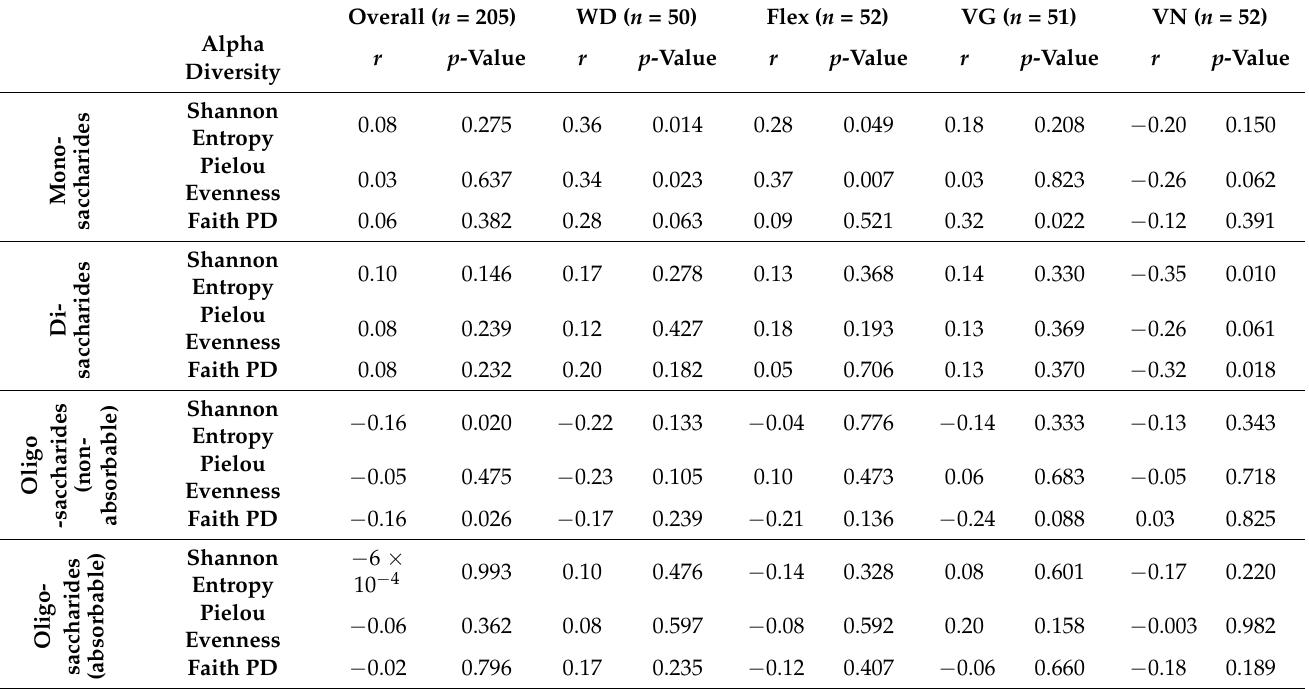
Table 10. Pearson correlations between mono-, di-, and oligosaccharides and alpha diversity in diet